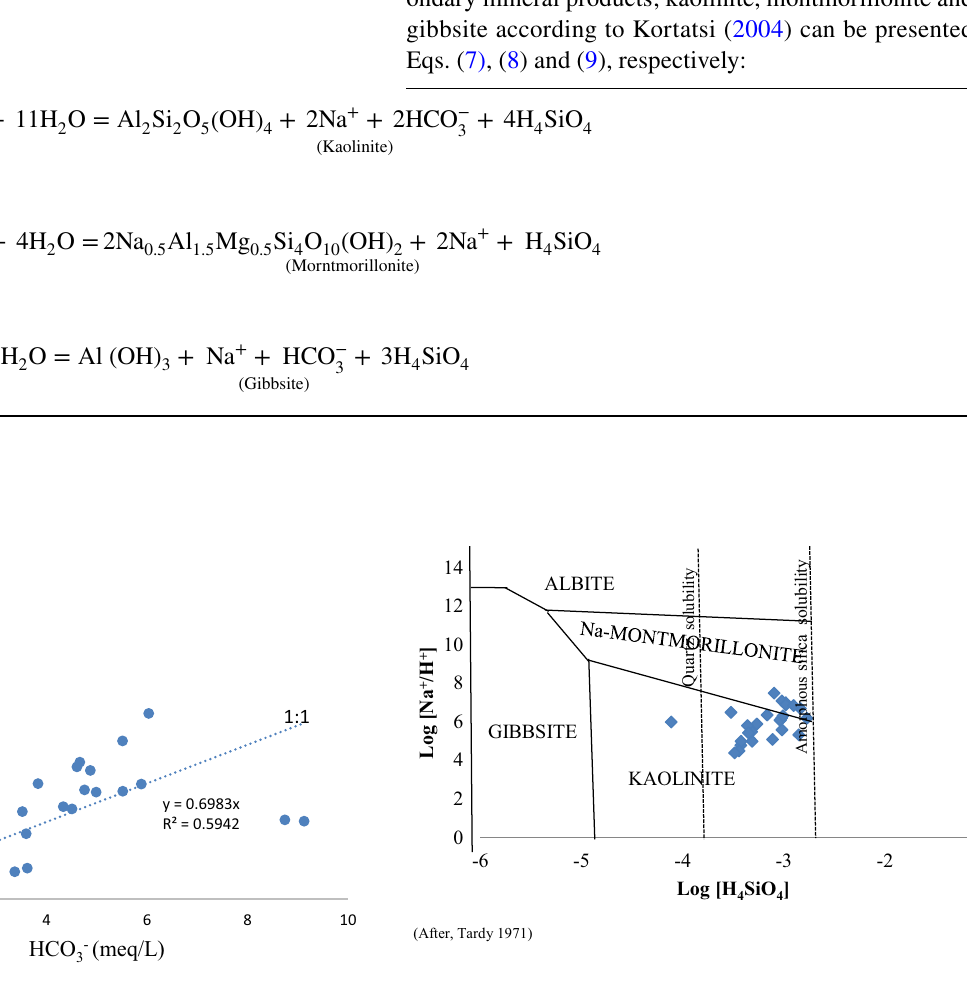
Fig. 9 The stability of albite and its possible secondary weathering products gibbsite, kaolinite and Na-montmorillonite with respect to groundwater within the Asutifi-North